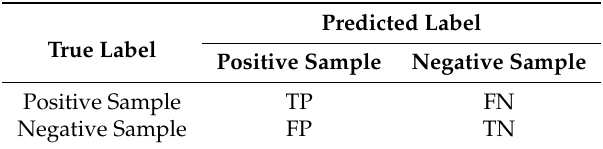
Table 4. The definition for different terms in Equations (4) and (5) are